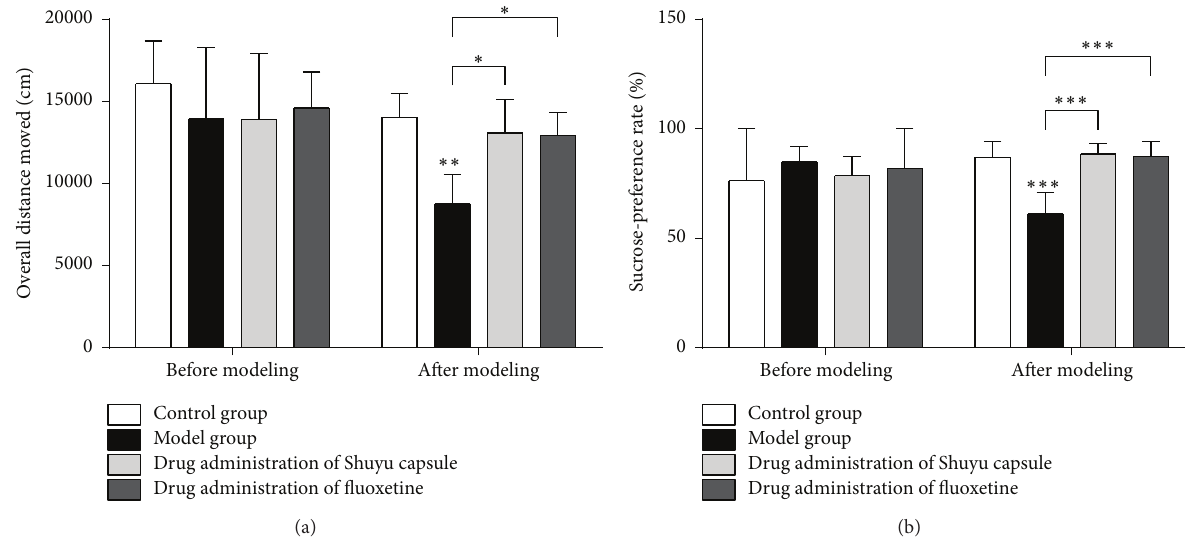
Figure 1: Behavioral assays. (a) Open-field test. (b) Sucrose-preference test. For all assays, testing was performed both before model building and after model building. Moreover, the following groups were analyzed: (1) the control/normal group (white), (2) model group (black), (3) Shuyu capsule group (gray), and (4) positive-control fluoxetine group (charcoal gray). The statistical analysis for the behavior assays was performed by one-way ANOVA ( 𝑛 = 18 , ∗ 𝑃 < 0.05 , ∗∗ 𝑃 < 0.01 , and ∗∗∗ 𝑃 < 0.001